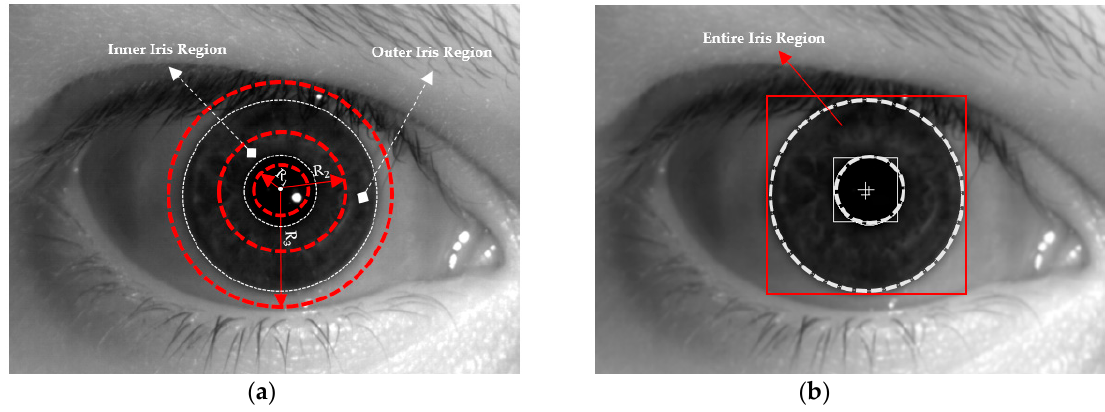
Figure 3. Definition of local and global iris region: ( a ) inner and outer local iris region (two donut shapes between three red circles whose radiuses of R 1 , R 2 , and R 3 ), and ( b ) entire iris region (rectangular box).